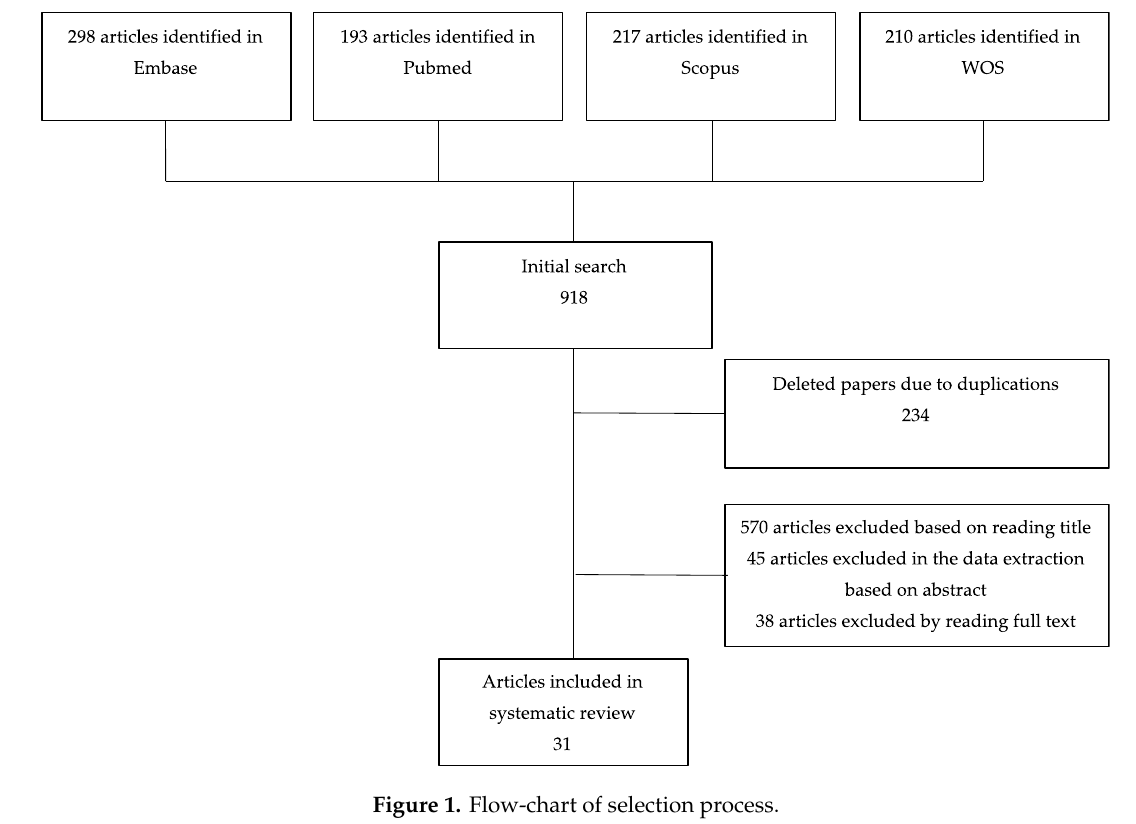
Figure 1. Flow-chart of selection process.